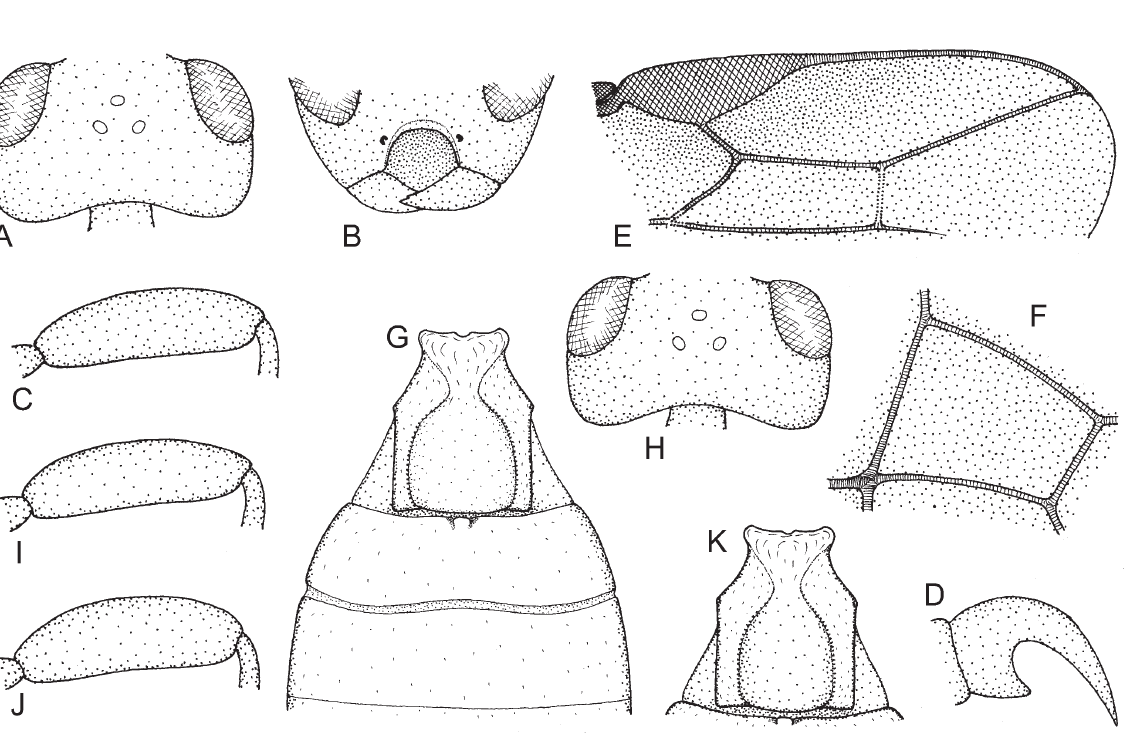
Fig. 52. Bracon ( Glabrobracon ) caudiger Nees, 1834 (A-G: ♀ neotype, H-K: ♀ / ♂). A . Head in dorsal view. B . Head in frontal view. C . Hind femur. D . Claw. E . Distal part of right forewing. F . First discal cell of right forewing. G . Tergites 1-3. H . Head in dorsal view. I-J . Hind femur. K . First